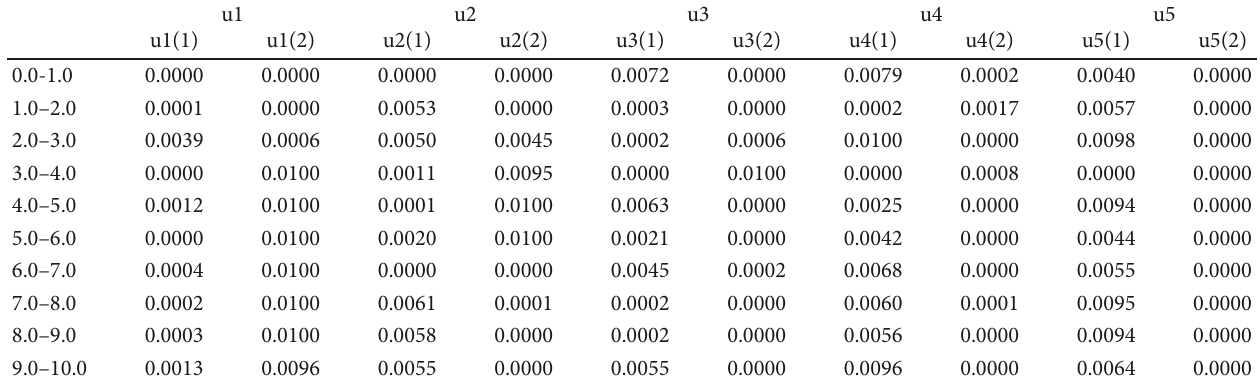
Table 7: Five solutions selected from the front for case